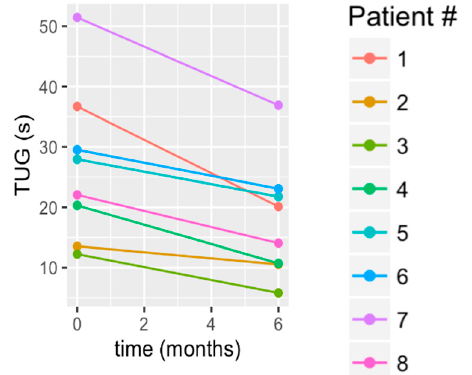
Figure 6. Change in the Timed Up and Go (TUG) test from baseline to 6 months.